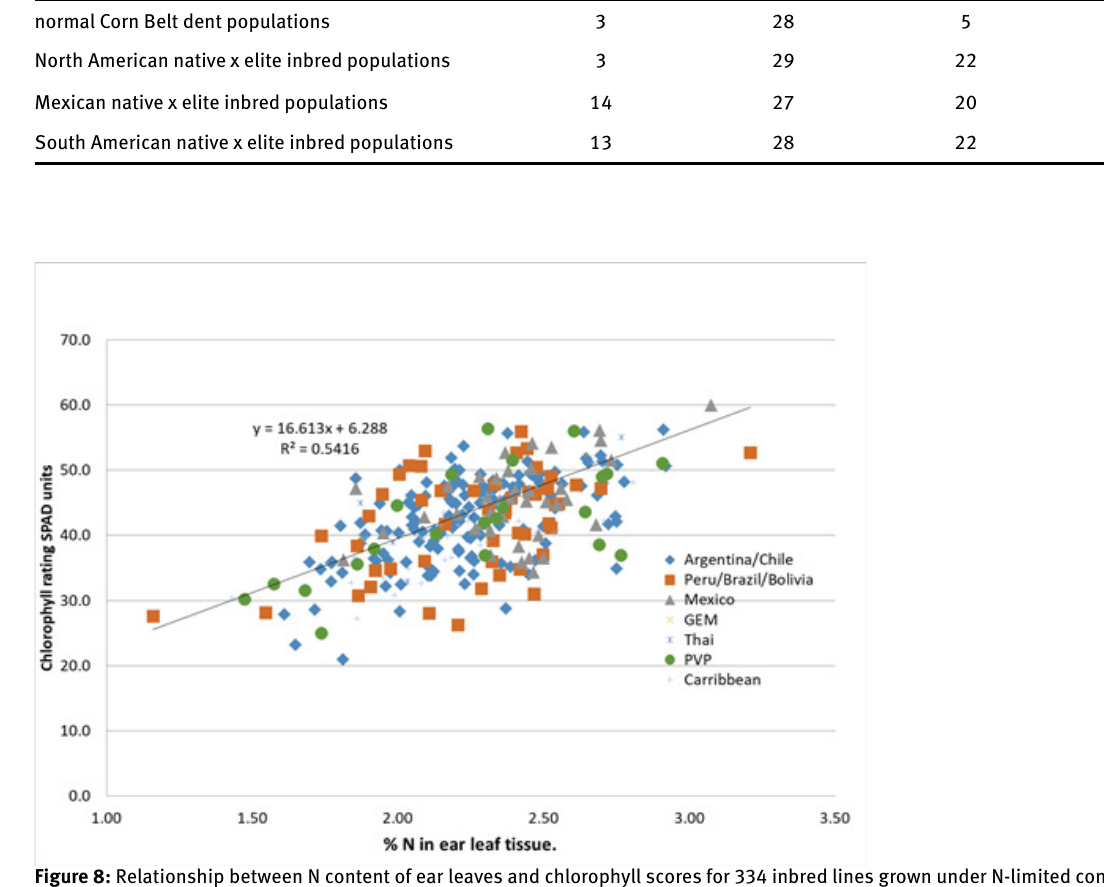
Cultivar no breeding lines